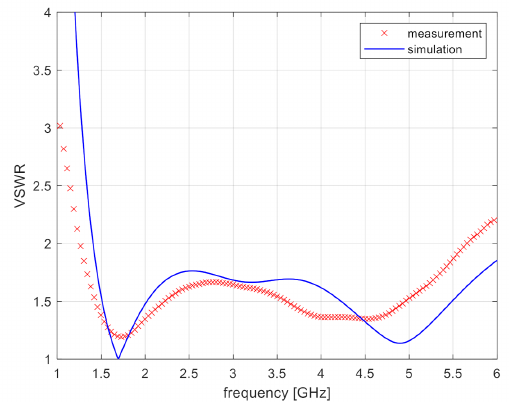
Figure 19. The impedance matching of prototype antenna for on-body location for 10 mm distance from the